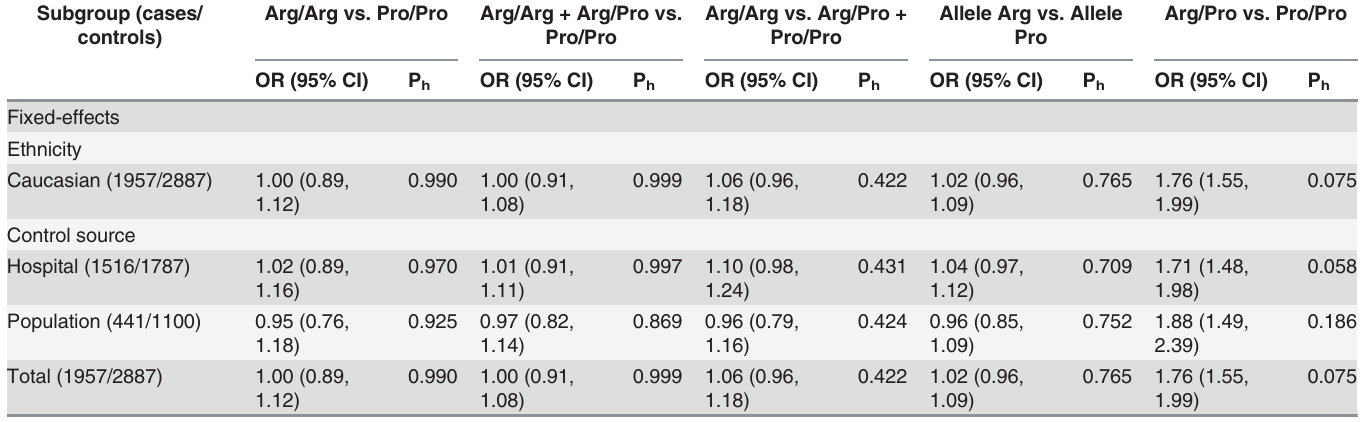
Table 2. Meta-analysis for the association between the p53 Arg72Pro polymorphism and CM risk. Subgroup (cases/